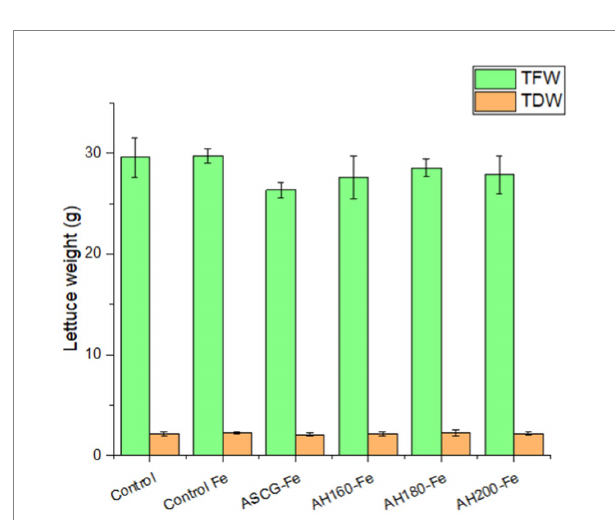
FIGURE 2 Total fresh weight (TFW) and total dry weight (TDW) of lettuce from different treatments after 40 days of cultivation. The bars represent the standard deviations of the means ( N = 4). The absence of letters indicates absence of statistically significant differences ( p <